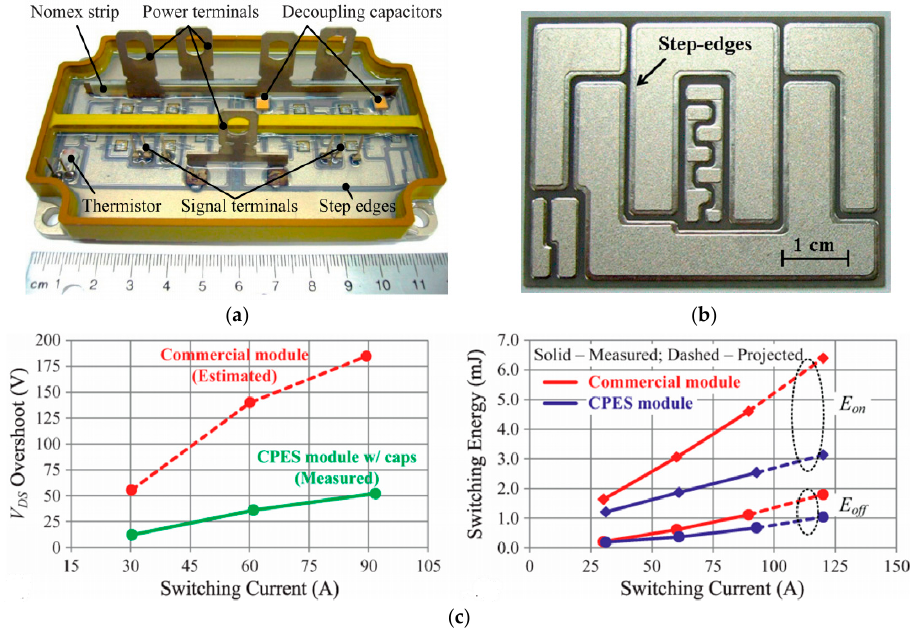
Figure 4. ( a ) Photograph showing the power module; ( b ) step edge technology for improved reliability at high temperatures; and ( c ) a comparison of switching performance between the (Center for Power Electronics Systems (CPES) module and a comparable commercial product.